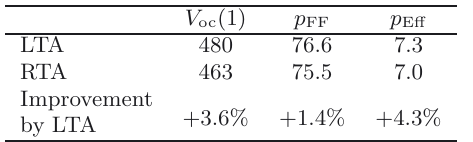
Fig. 8. Schematic diagram of experiment for LTA and RTP comparison. Table 1. Laser annealing and rapid thermal annealing